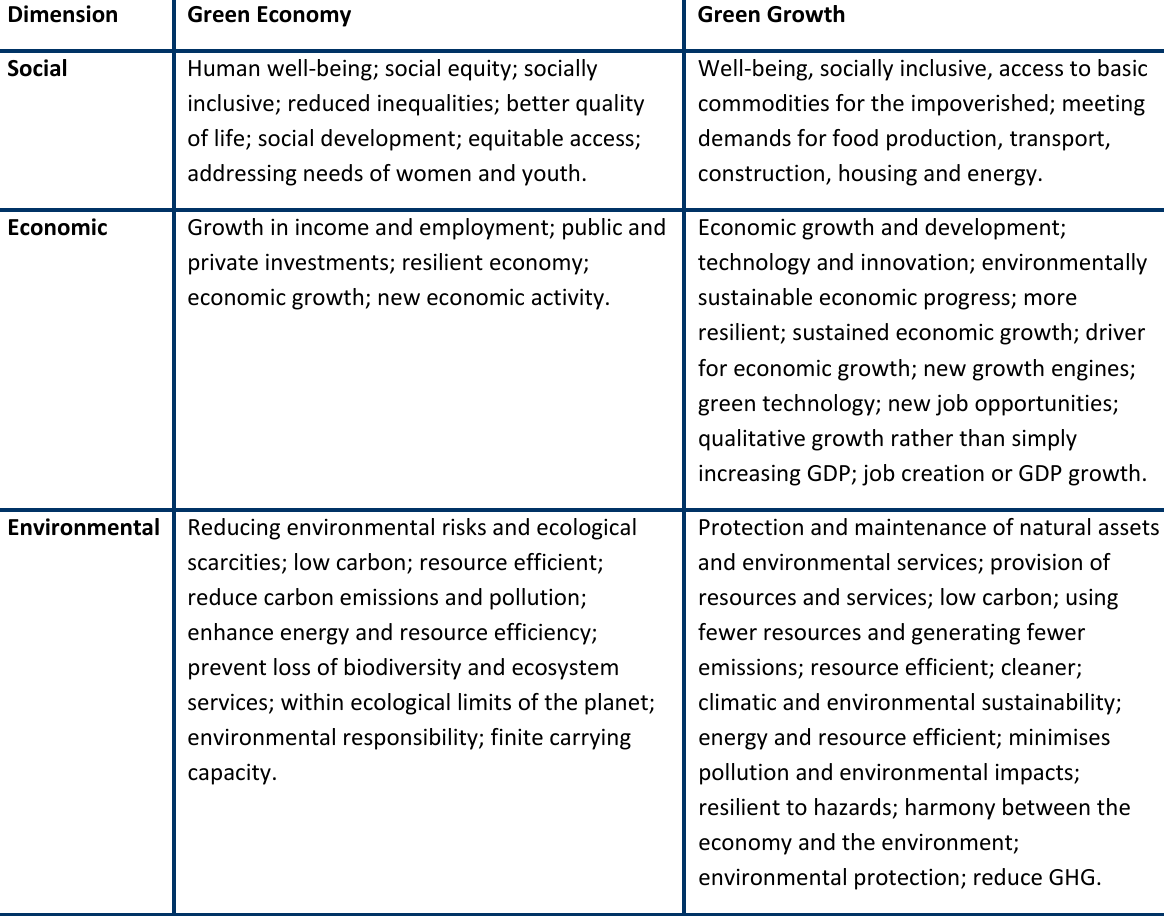
Table 1: Keywords in published definitions of Green Economy and Green Growth Dimension Green